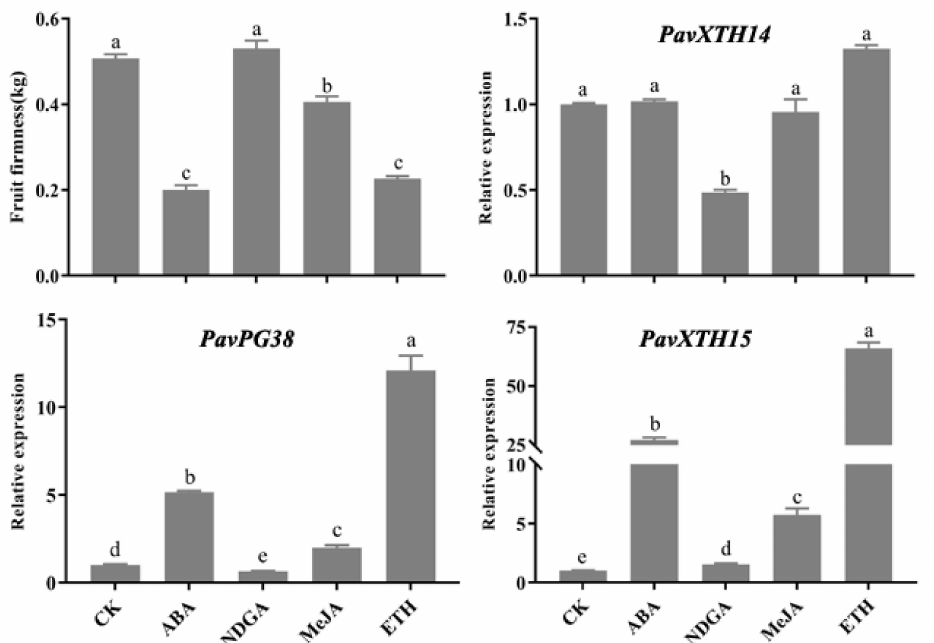
Figure 6. Changes in firmness and expression of PavPG38 , PavXTH14 , PavXTH15 after ABA, NDGA, MeJA and ETH treatments. ABA, abscisic acid; NDGA, nordihydroguaiaretic acid; MeJA, methyl jasmonate; ETH, ethephon. PavActin (Gene bank: FJ560908) was used as an internal control. The error bars represent the ± SD of three biological replicates. Different letters refer to significant differences by Duncan’s multiple range test with p <